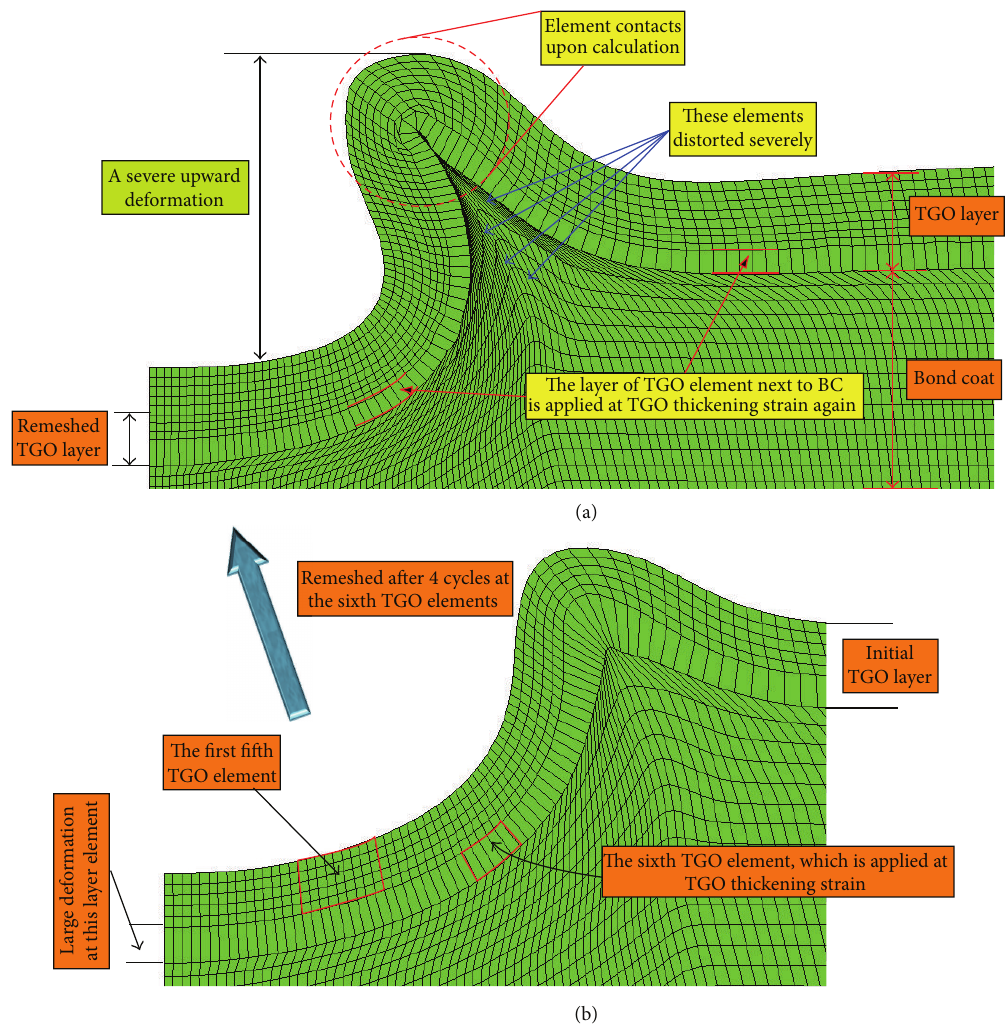
Figure 4: The deformation profile for the simulated FEM model. (a) The remeshed mesh configuration and (b) the deformation profile after the first four thermal